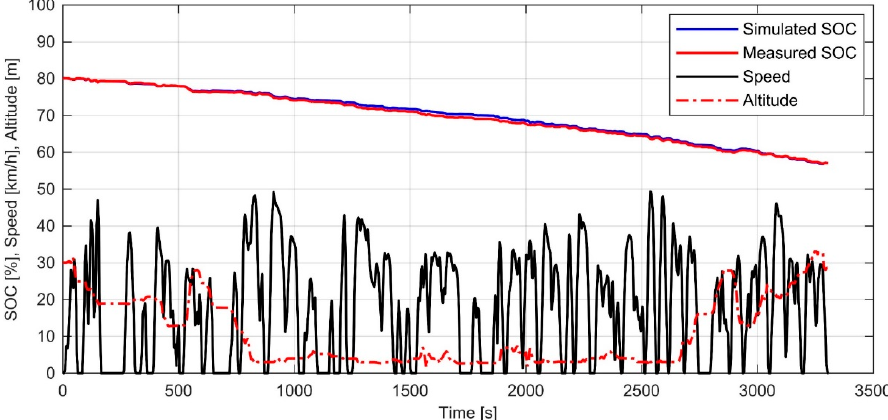
Figure 9. Electric bus simulation model validation graphs.